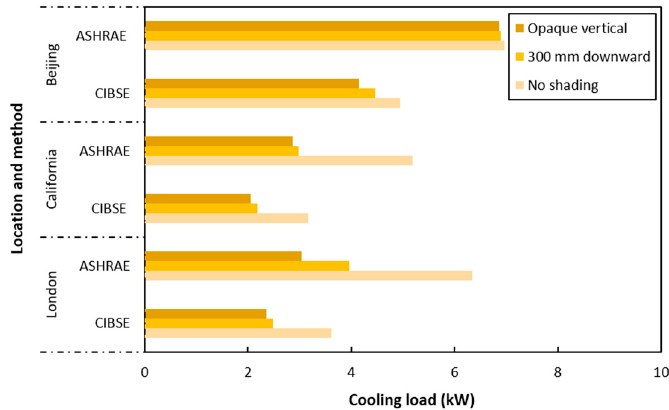
Figure 7. Shading device impacts on peak heat gains.